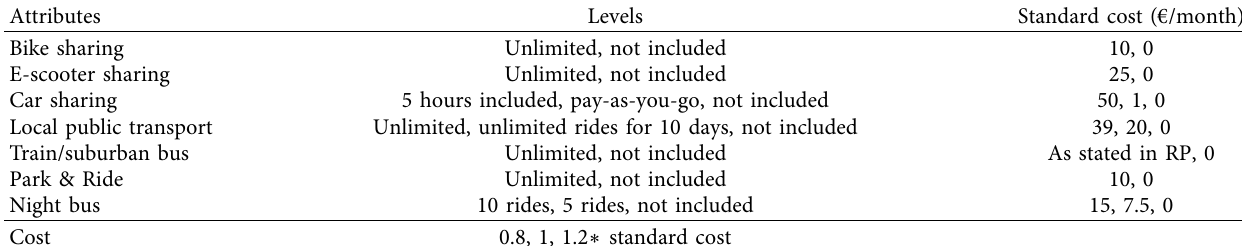
Table 1: MaaS package